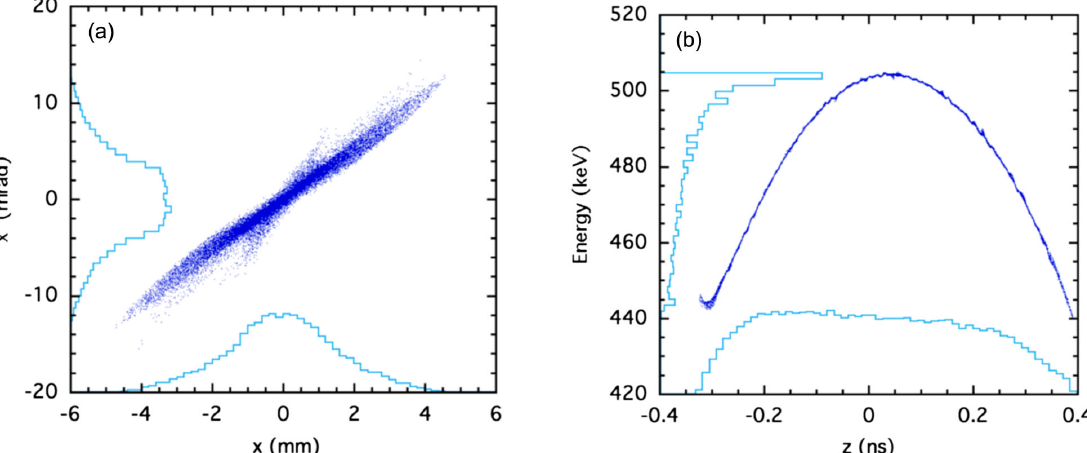
FIG. 7. Particle distributions in horizontal (a) and longitudinal (b) phase spaces at the 238-MHz rf cavity exit obtained with PARMELA